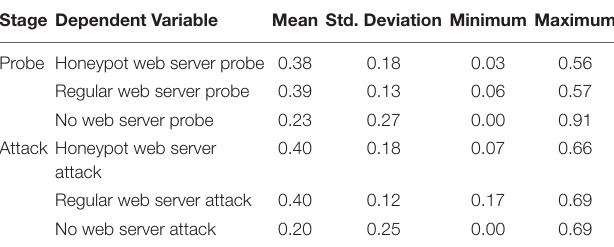
TABLE 2 | Descriptive statistics for different dependent variables in the experiment. Stage Dependent Variable Mean Std. Deviation Minimum Maximum